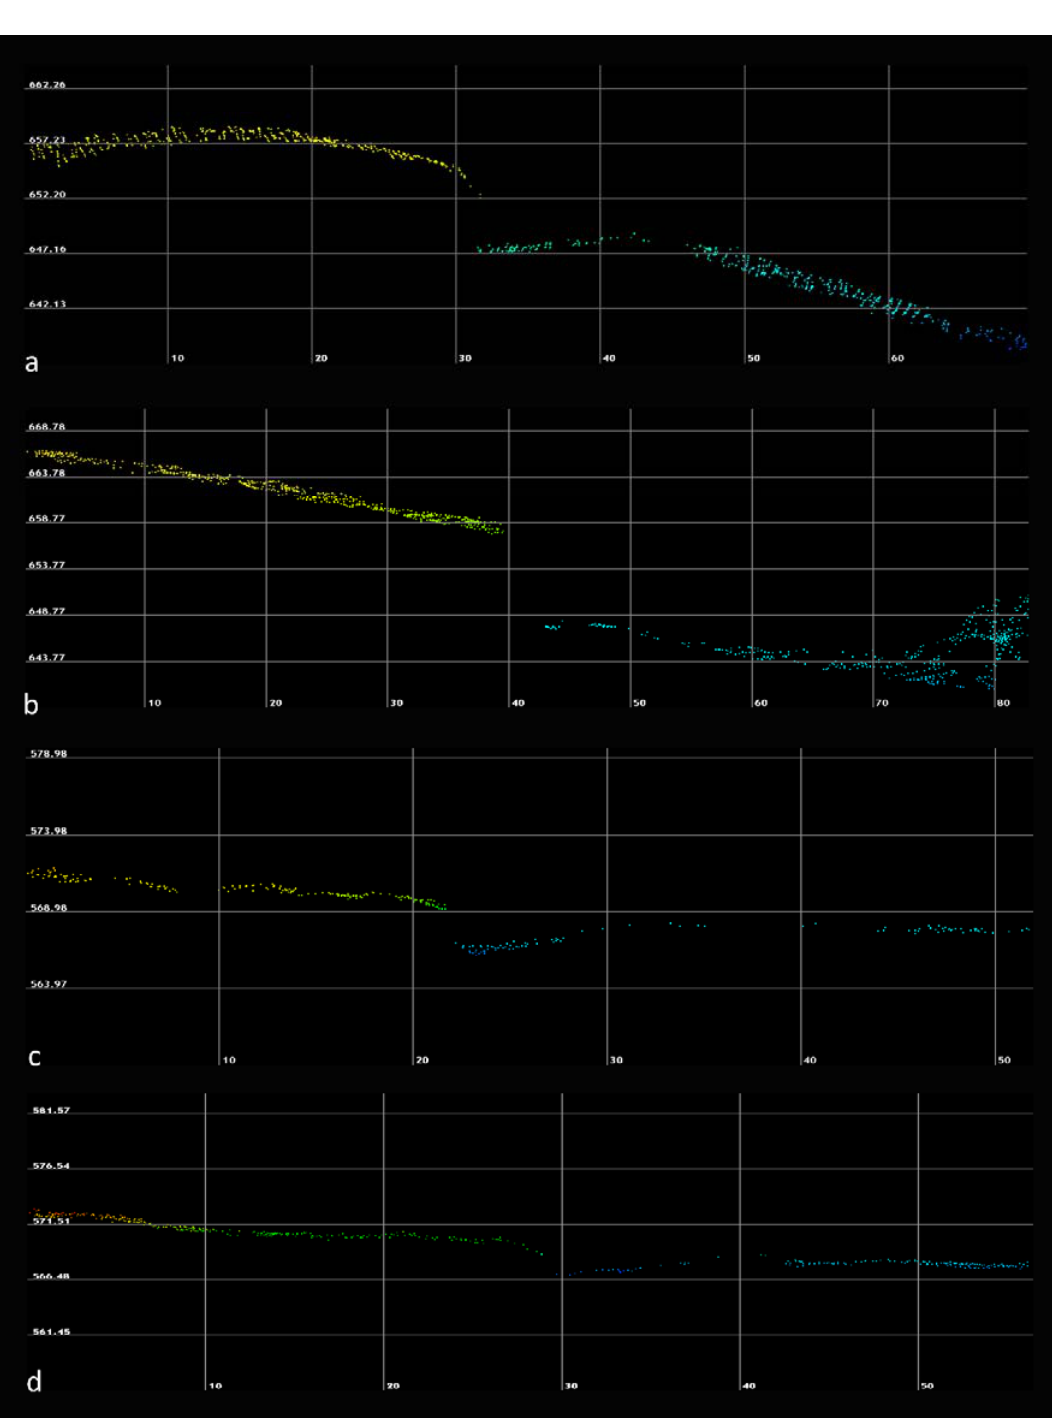
Figure 9. Point cloud profile images of four horizonal cave entrances rendered in LP360: ( a ) large entrance, Bird Tower Cave; ( b ) medium-sized entrance, Eduardo Quiroz Cave; ( c ) small entrance, Actun Uo (Uo Frog Cave); and ( d ) fissure entrance, Actun Z’uhuy Ch’en (Untouched Cave).